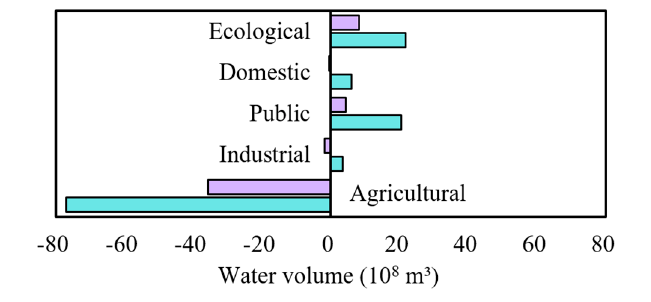
Figure 14. Results of water allocation in 2016 (symmetric and asymmetric).